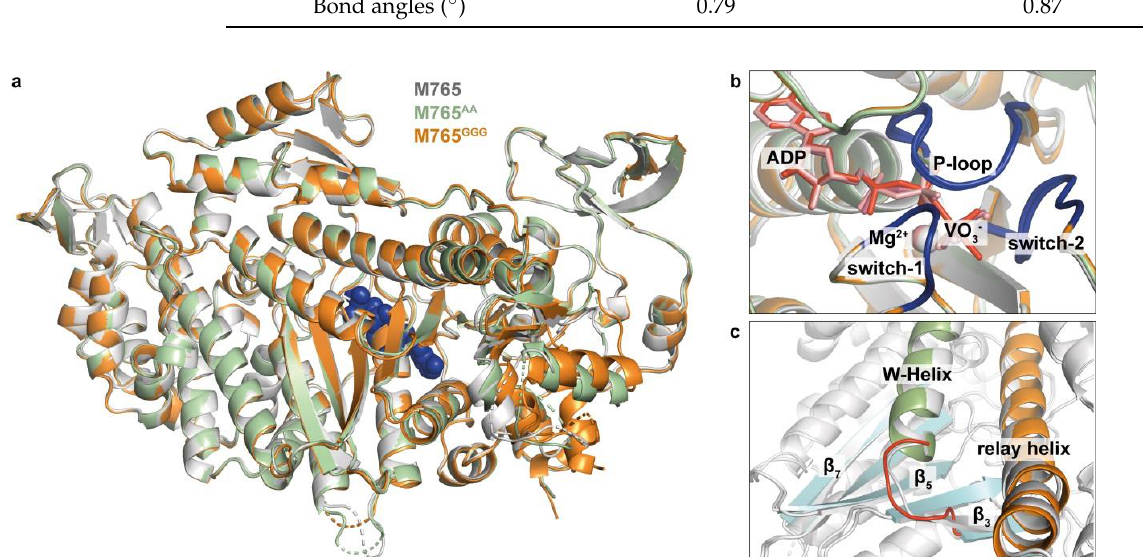
Figure 2. X-ray crystal structures of the Dd myosin-2 motor domains of wildtype myosin M765 (pdb:1VOM) and mutant myosins M765 AA (pdb:7B1A) and M765 GGG (pdb:7B19) in complex with ADP∙VO 42- . ( a ) Superposition of the structures. M765 (white), M765 AA (green), M765 GGG (orange). The nucleotide is shown in blue. ( b ) Close-up view of the nucleotide- binding pocket. The active site elements switch-1, switch-2, and P-loop adopt the same conformation in wildtype and mutants. ( c ) Close-up view on the W-helix/transducer region. In the M765 GGG structure (orange) small conformational shifts are visible for the β 3, β 5, and β 7 sheets of the transducer (cyan) and the C-terminal end of relay helix (orange). The longer W-loop in M765 GGG prevents proper β 3-sheet